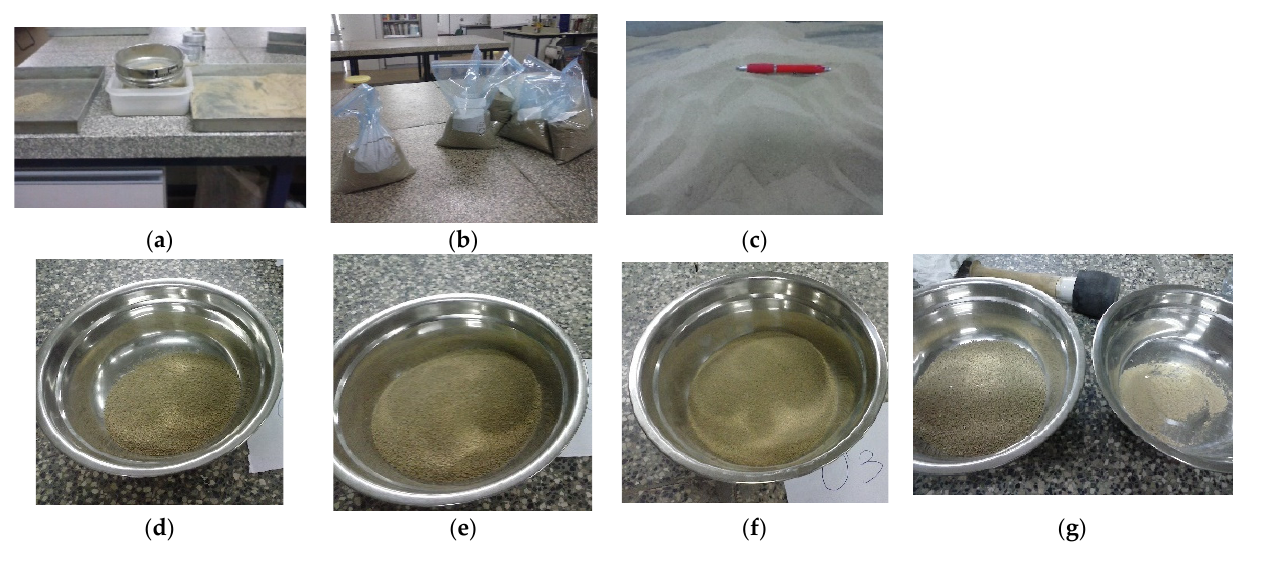
Figure 1. Preparation of the tested sand sample: ( a ) particles larger than 1.25 mm sieve removed; ( b ) bags classified with each particle size fraction; ( c ) final sample of sand tested after mixing the proper amount of the corresponding sieves; ( d ) 0.63 mm sieve; ( e ) 0.4 mm sieve; ( f ) 0.32 mm sieve; ( g ) 0.16 mm and 0.08 mm sieves. Table 1. Cumulative %-weight passing after sieving analysis [19].